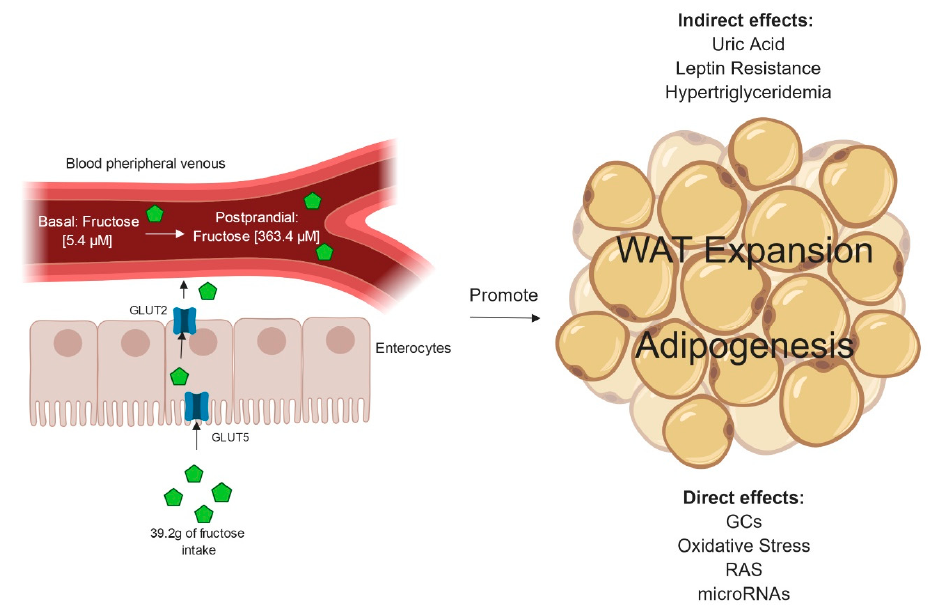
Figure 1. Chronic fructose intake induces white adipose tissue (WAT) expansion. Chronic